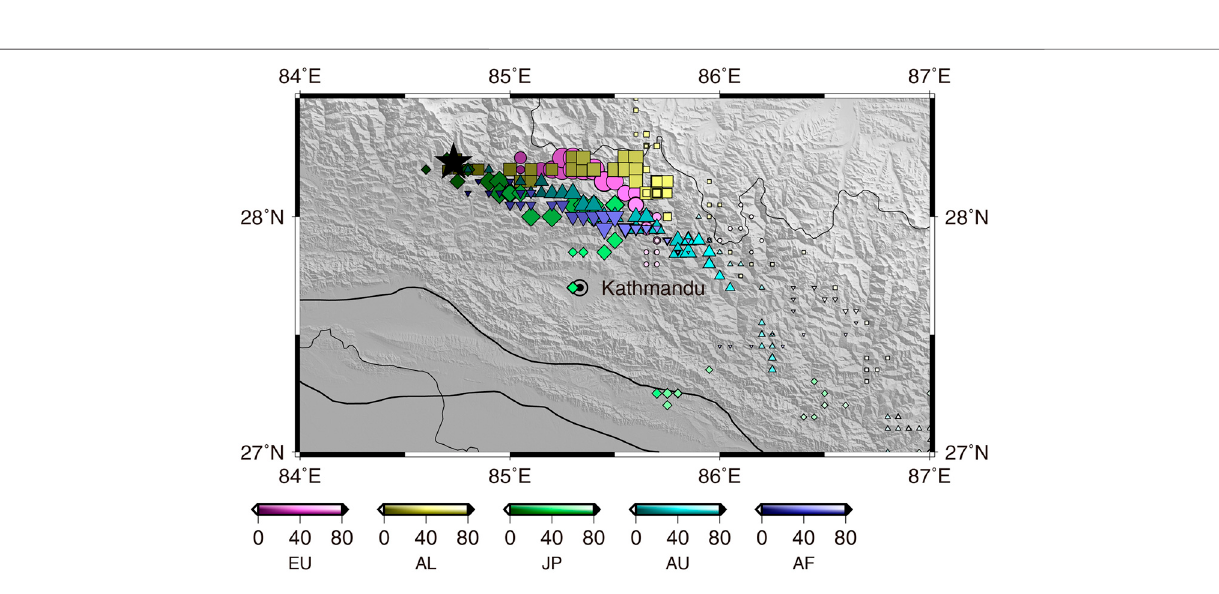
Frontiers in Earth Science |